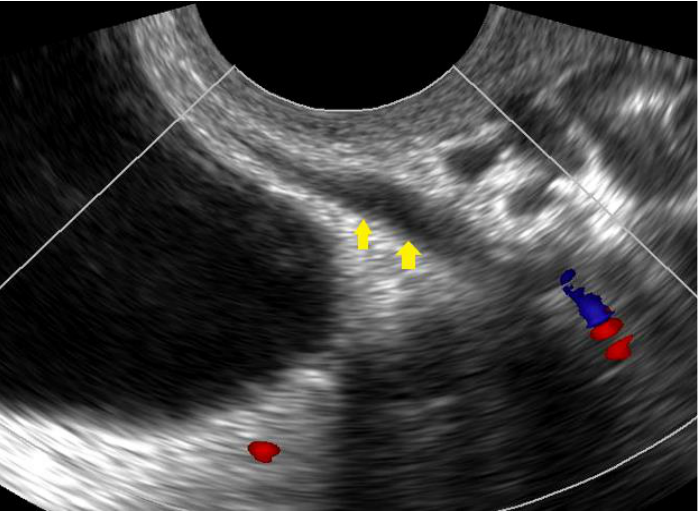
Figure 5. Ultrasound image showing the distal part of the ureter (yellow arrows) before it enters the bladder.